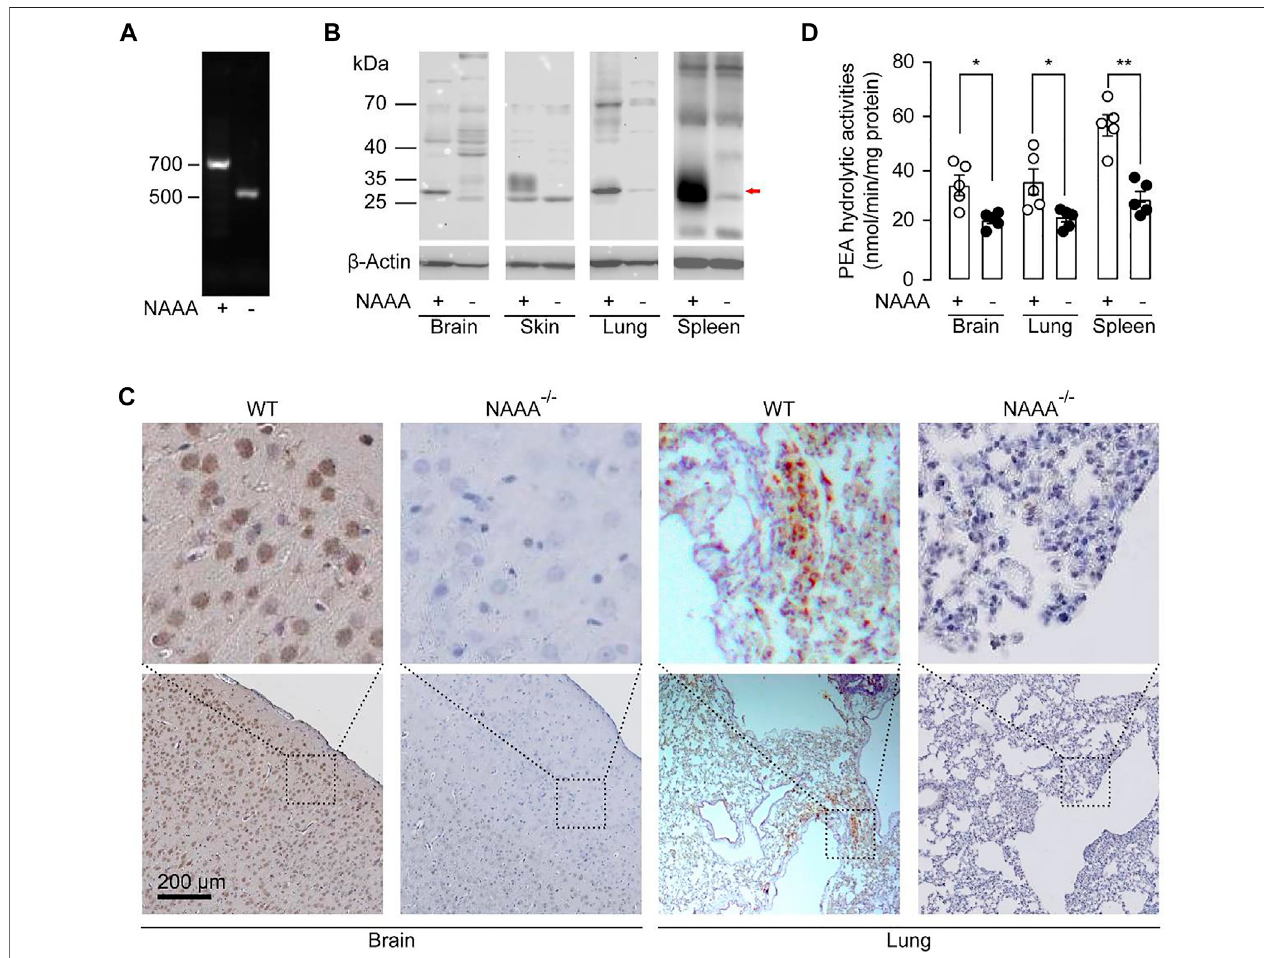
FIGURE 1 | Characterization of NAAA -/- mice. ( A) Tail genomic analysis of WT and NAAA − /- mouse by PCR. (B) Representative western-blot bands of NAAA abundances in the spleen, lungs, brain, and skin from WT and NAAA -/- mice. (C) Representative immunohistochemical analyses of NAAA in the brain and lung sections fromWTandNAAA − /- mice. (D) PEAhydrolyticactivitiesweretestedinthelysosomalfractionofbrain,lungsandspleenhomogenatesfromWTandNAAA − /- mice,atpH 4.5. Data are expressed as mean ± SEM ( n (cid:1) 5). *, p < 0.05; **, p < 0.01 by t